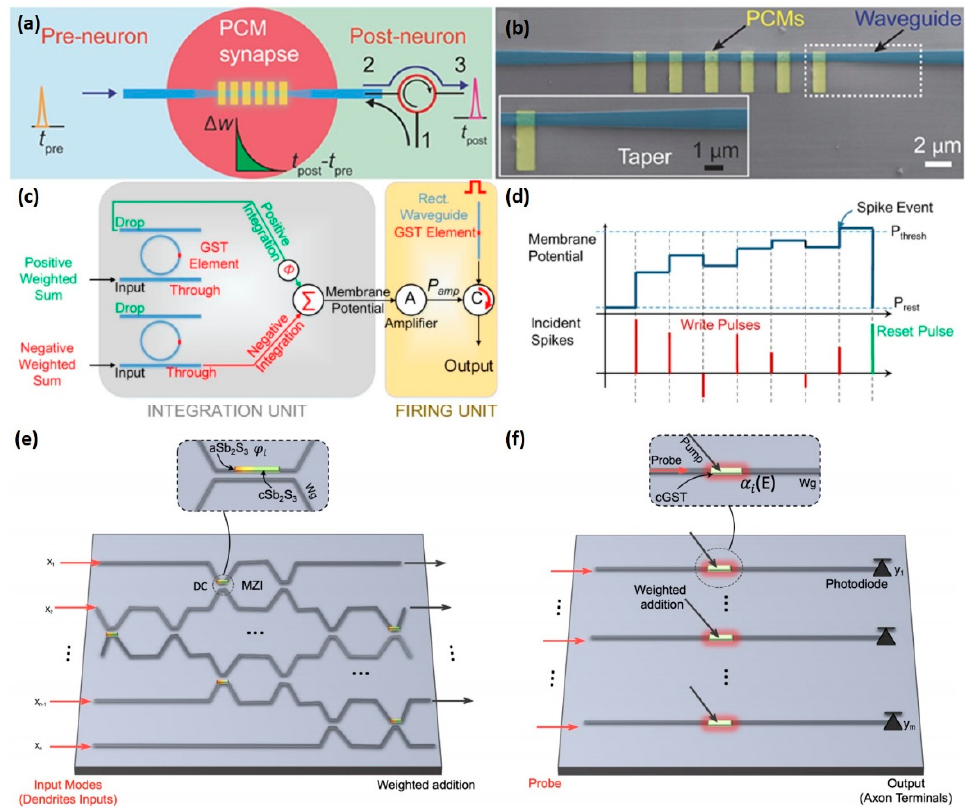
Figure 8. Various recent implementations for photonic neuromorphic computing. ( a ) Schematic of integrated photonic synapse functionally resembling a biological neural synapse where a waveguide is covered with islands of PCM, forming a connection between the pre-neuron and post-neuron parts of the circuit. The post-neuron section contains a circulator (red circle) used to route the output from the synapse to the postsynaptic region and weight (control signals) from port 1 to synapse. ( b ) SEM image of the photonic synapse presented in ( a ). ( c ) Schematic of a bipolar integrate-and-fire neuron implemented using a GST patch straddling on ring resonators. ( d ) Timing diagram of the bipolar integrate-and-fire neuron presented in ( c ) showing integration of membrane potential under various incident pulses. ( e ) An artificial photonic neuron based on PCM. The weighting mechanism and summation rely on a cascade of Sb 2 S 3 –SiN hybrid photonic switches which perform operations equivalent to that of a field-programmable gate array (FPGA). Upon placing PCM on one side of the directional coupler (DC), light is partially configured to the cross state following the material being written (crystalline to amorphous). ( f ) Nonlinear activation function (NLAF) made with GST patches on a silicon waveguide. Nonlinear variations in refractive index are sensed with TM polarized light. (( a , b ) reproduced under creative commons license [95]; ( c , d ) reproduced under creative commons license [23]; ( e , f ) reproduced under creative commons license from article